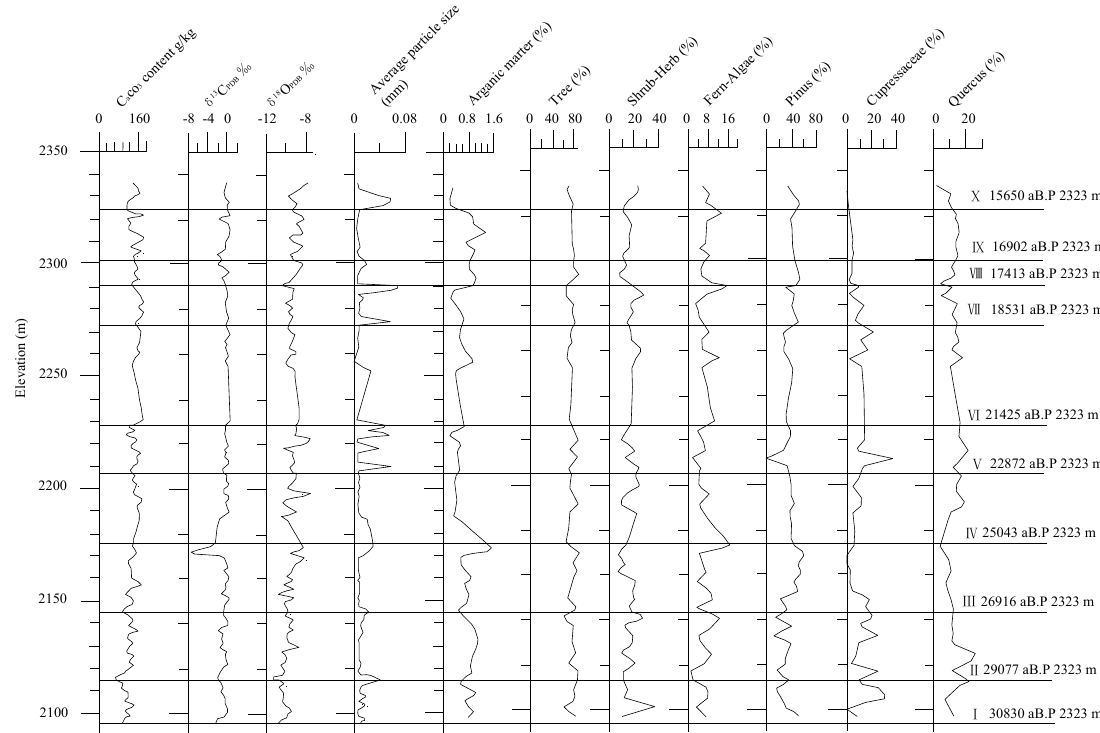
Fig. 12. Delineation of paleoclimate in the study area Figure 12. Delineation of palaeoclimate in the study area.